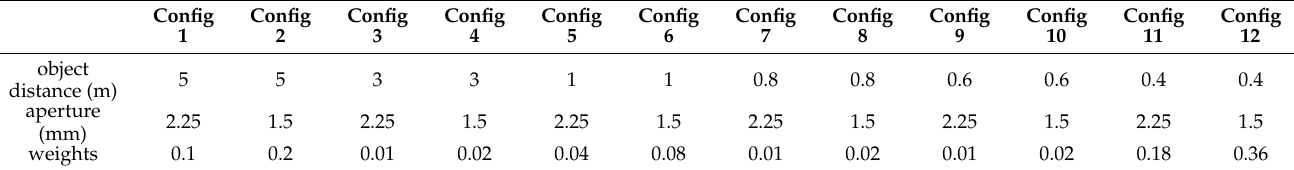
Table 2. Settings of the multi-configuration editor.